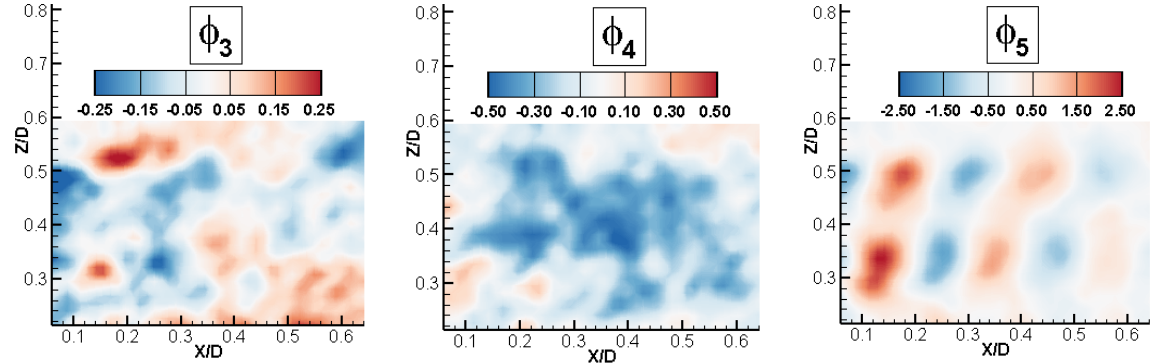
Figure 8. Velocity-based POD mode shapes for R1 region.